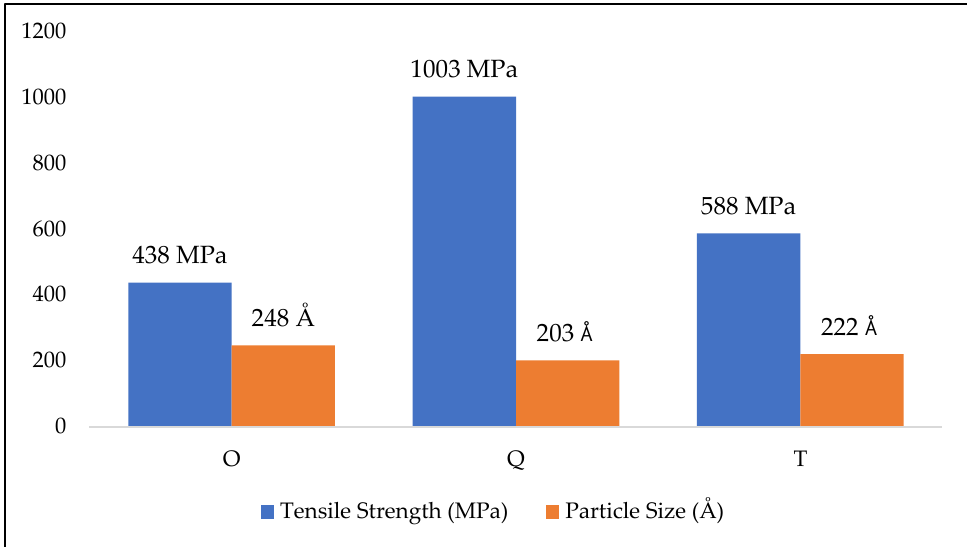
Figure 13. Tensile strength vs. Particle size .